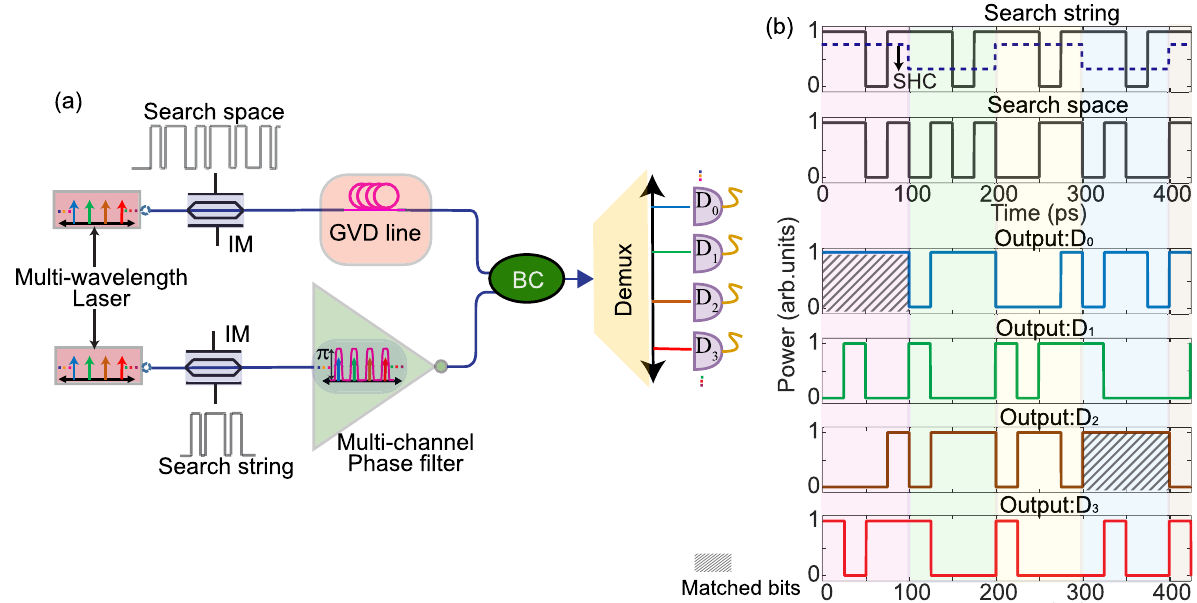
Fig. 4 | Proposal for a multichannel FBG-based pattern matching algorithm. a Schematic illustrating the operational principle wherein the demonstrated fully passive XNOR logic can be extended to realize an all-photonic pattern matching algorithm by employing a multi-wavelength laser, a group-velocity dis- persive (GVD) line (providing a 1-bit wavelength dependent shift), and a multi- channel FBG-based phase fi lter. IM: intensity modulator. Demux: Wavelength- division demultiplexer. b Numerical simulations representing pattern matching of a4-bitsearchstring:{1101}withina16-bitsearchspace:{1101010100110100}. Notice that the search string is programmed to repeat twice within the search space. Bit sequences are encoded in the NRZ-OOK format at a bit rate of 40 Gbps. Photodetector signals (D i ) correspond to the XNOR output of the i th − bit shifted